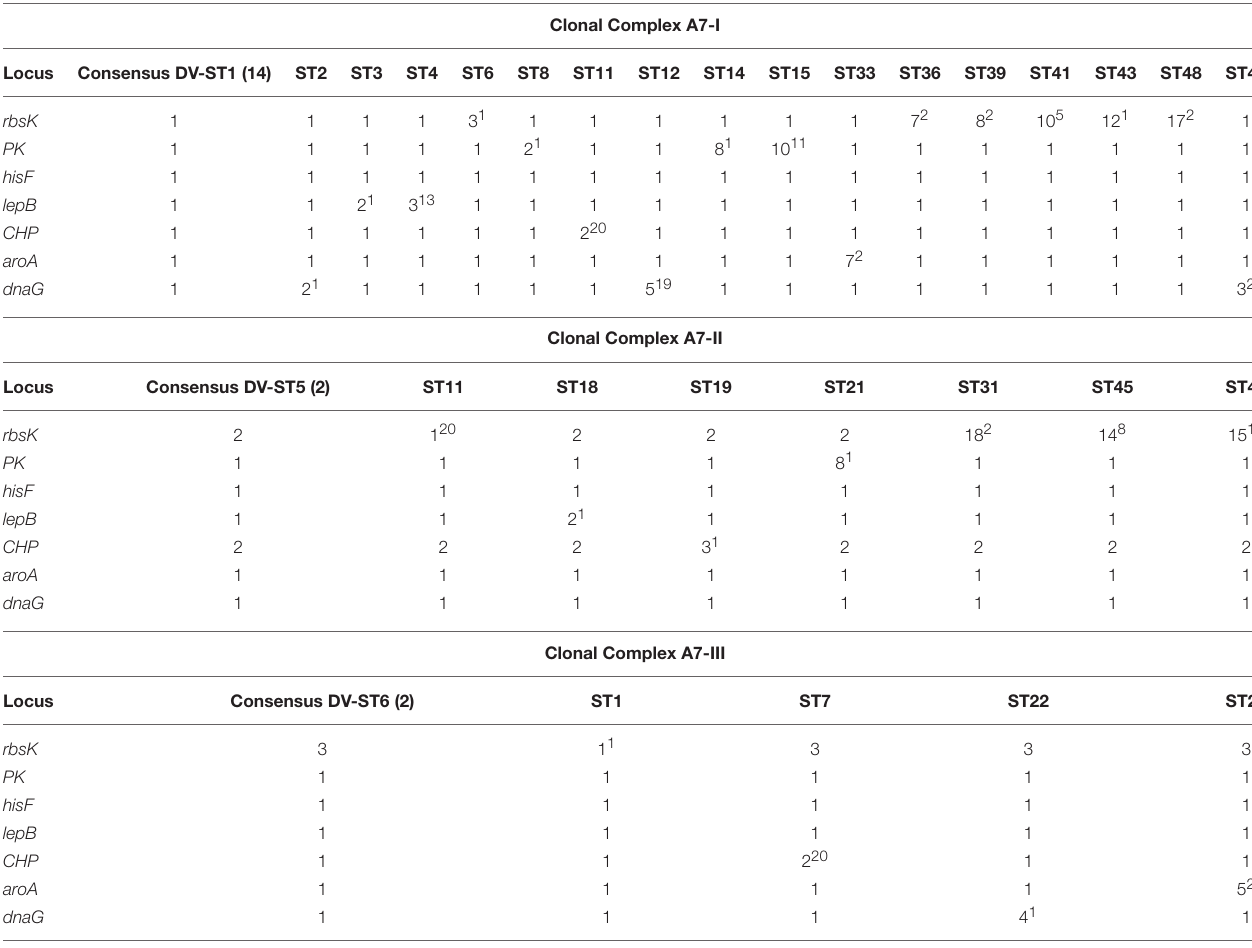
The number of BACs within an ST is in parentheses when greater than 1. Superscripts next to the allele number denote number of nucleotide differences compared to the consensus sequence. Corresponding to Figure 4 . DV, dominant